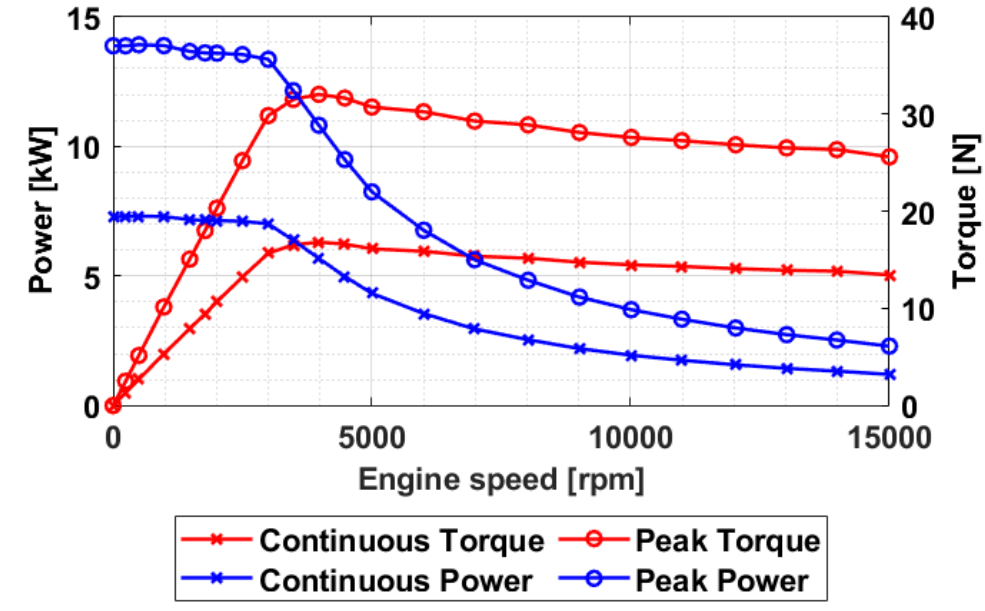
Figure 4. Power and torque curves of the motor-generator.